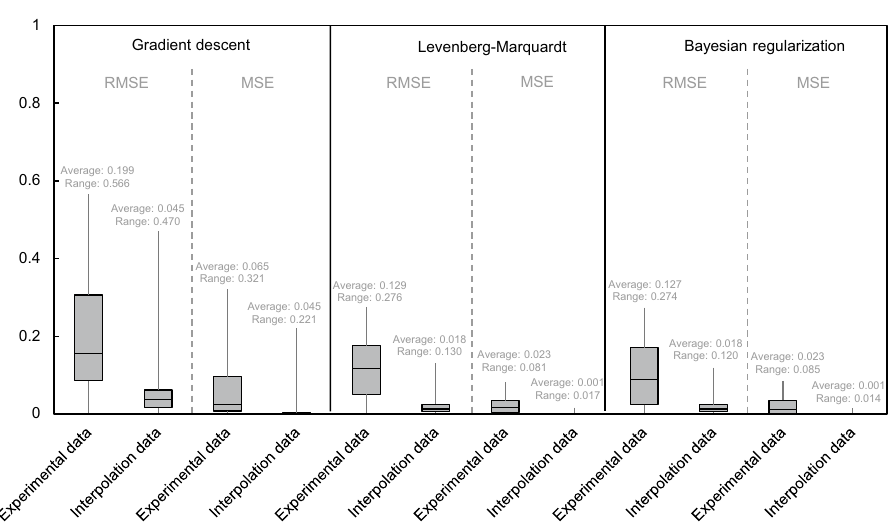
Figure 12. Comparison between the predicted and actual safety factors based on linear regression: ( a ) gradient descent algorithm; ( b ) Levenberg–Marquardt algorithm; ( c ) Bayesian regularization algorithm.